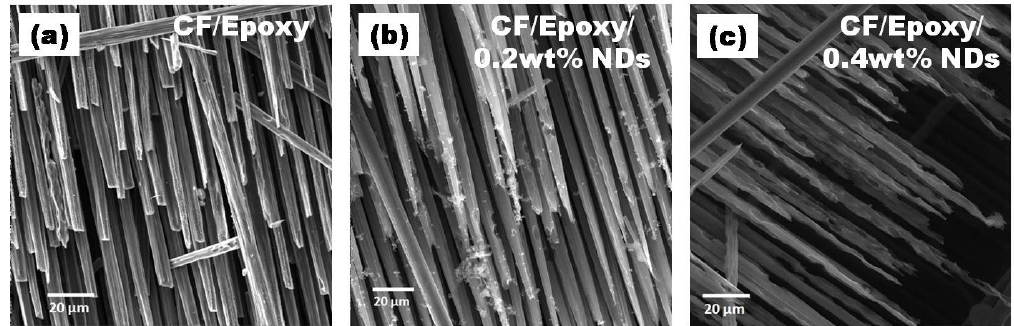
Figure 12. SEM images of CFRE-C ( a ) fiber fracture and ( b , c ) curved fiber toes due to uniform burning.